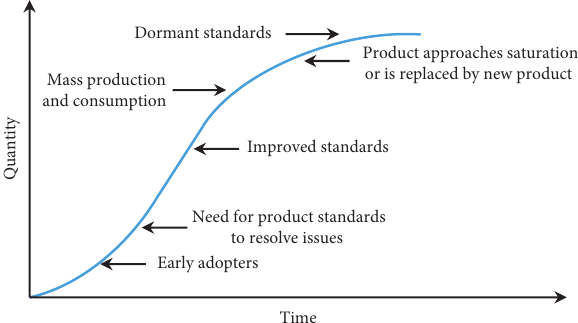
Figure 1: Product sales and standards cycle [15].